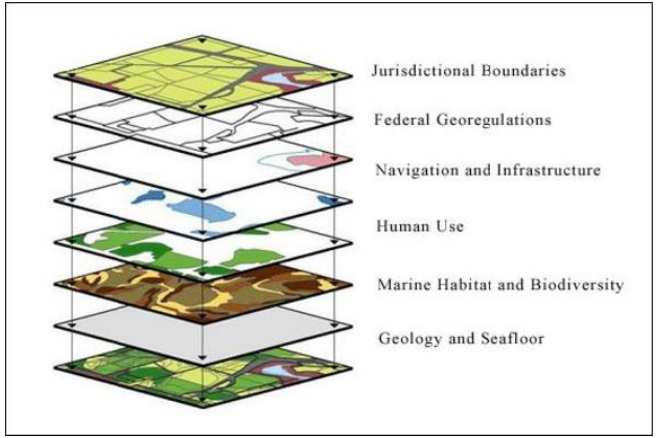
Figure 10. Data layers in an MSDI. Reprinted from Ref. [44]. Copyright 2010, Fowler et